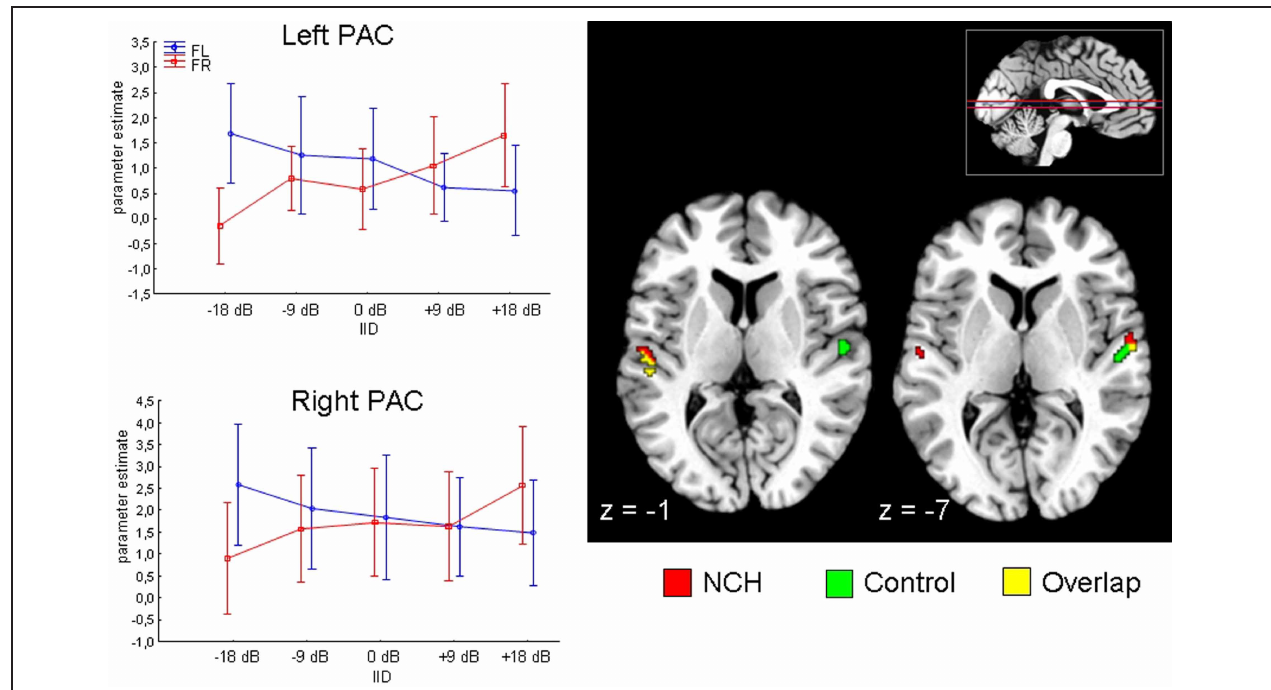
FIGURE 2 | Attention by IID interaction in the primary auditory cortex (PAC) projected on a brain template. Two axial slices are presented, at z-coordinate − 1 and − 7 (position of slice presented with red horizontal lines on inset in the right corner). Results from NCH (red) and control group (green) are plotted separately for illustrative